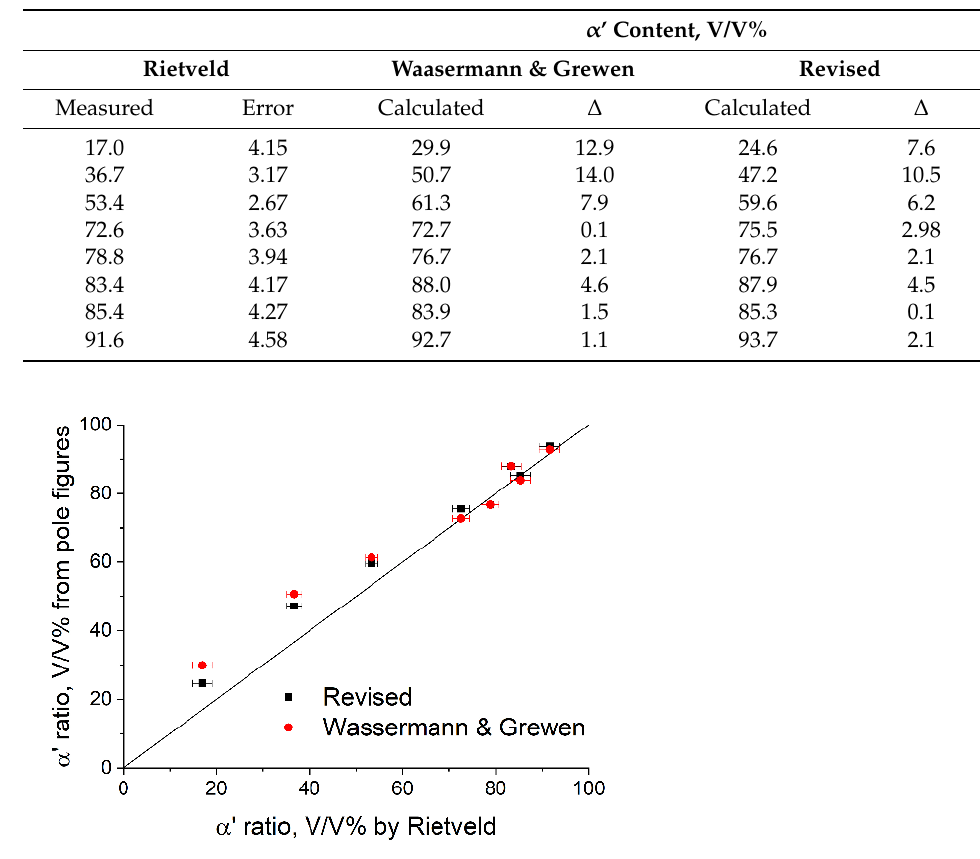
Figure 4. The ratio of α’ martensite in the prepared α’–γ powder mixtures determined with the Rietveld method and calculated from the pole figures using Wassermann and Grewen’s formula and the revised formula.